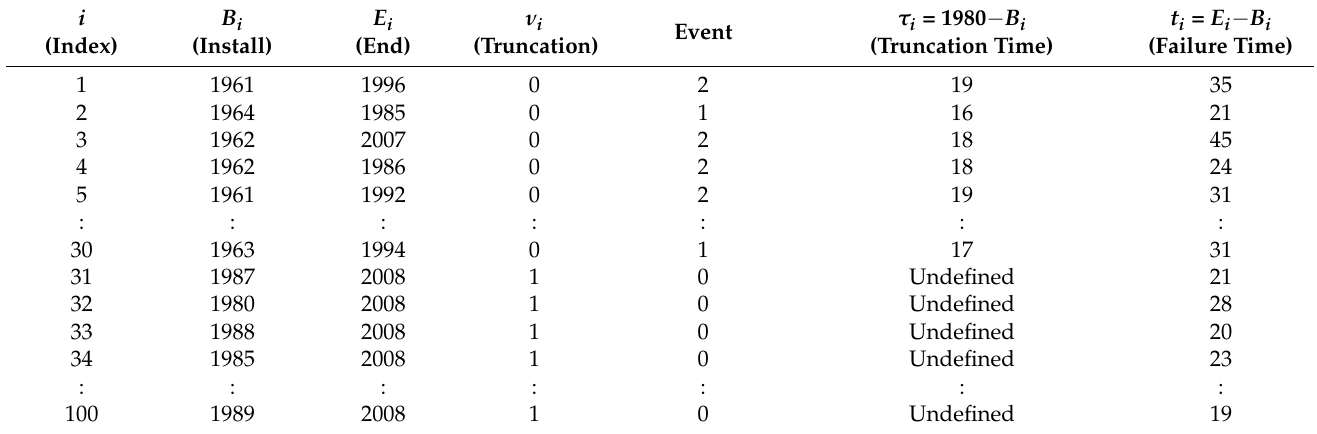
Table 5. Artificial data from Kundu et al. [26], which consist of n = 100 power transformers observed from the starting year ( s = 1980) to the ending year ( e = 2008). B i is the installation year. E i is either failure year or censoring year (2008). The 30 transformers are truncated ( ν i = 0) and other 70 transformers are untruncated ( ν i = 1). Observed events are shown in Event (=0 for censoring; =1 for Event 1; =2 for Event